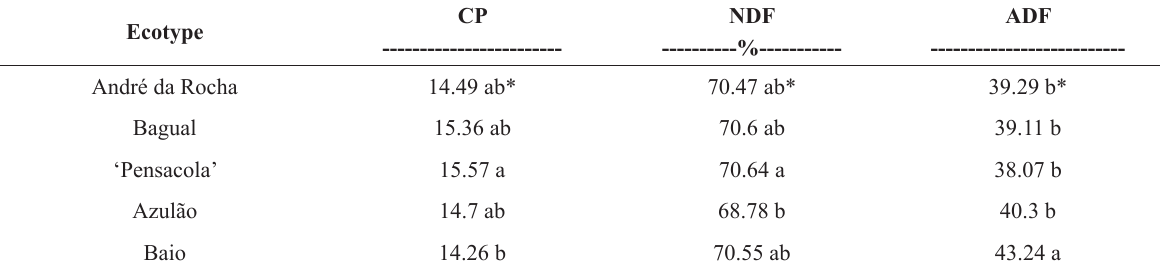
Content of crude protein (CP), neutral detergent fiber (NDF) and acid detergent fiber (ADF) of leaves in four ecotypes of Paspalum and cv. ‘Pensacola’, Eldorado do Sul.